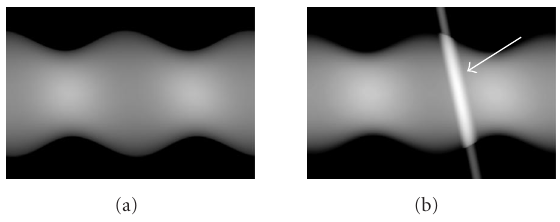
Figure 5: Sinograms formed with a 50 cm length detector by or- biting the source for one elliptical turn as shown in Figure 2. (a) Sinogram without the outside ellipsoid, (b) the counterpart sino- gram with the outside ellipsoid. The oblique strip pointed by the white arrow was due to the outside